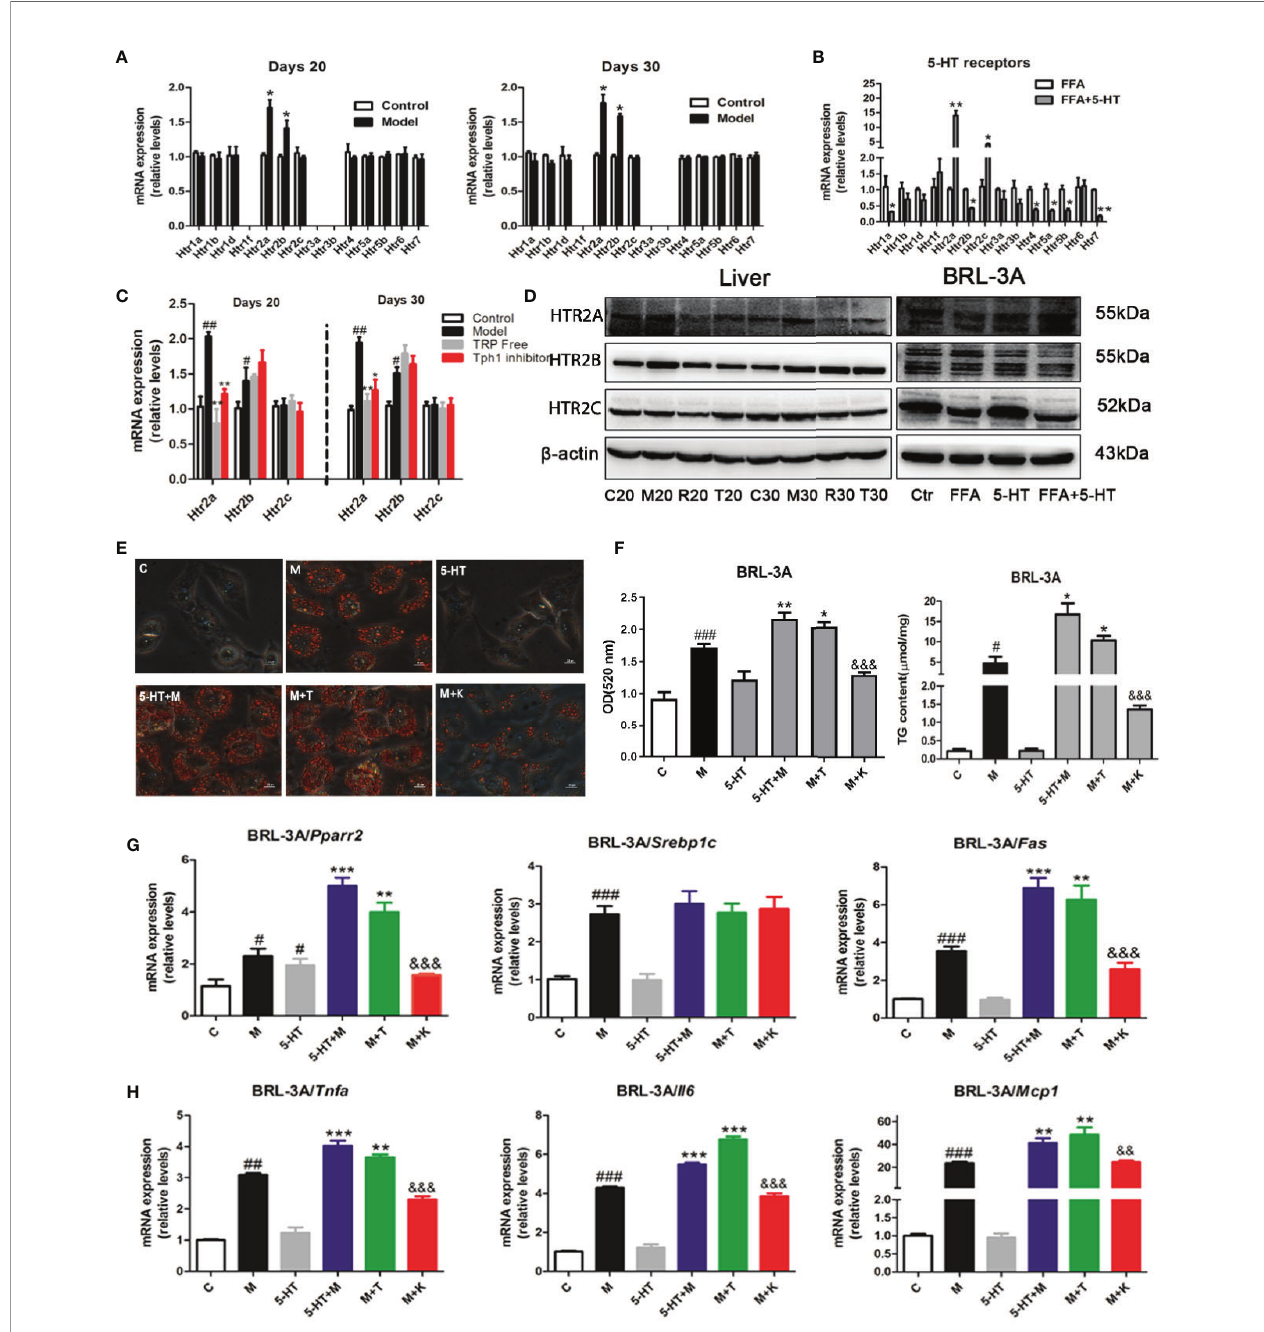
FIGURE 3 | Gut-derived serotonin (GDS) promoted lipid synthesis and the in fl ammatory response through the HTR2A receptor in hepatocytes. (A) Relative messenger RNA (mRNA) expression of 14 HTRs on day 20 and day 30 in SD rats. (B) Relative mRNA expression of 14 HTRs in BRL-3A. (C) Relative gene expression of Htr2a , Htr2b , Htr2c in SD rats administrated TRP Free diet and LP5333401. (D) The protein level of HTR2A, HTR2B, HTR2C in SD rats fed HFSD diet for 20 or 30 days and in BRL-3A treated by free fatty acid (FFA) or 5-HT. (E) Oil red O staining and lipid content in BRL-3A (× 400). (F) The content of TG in